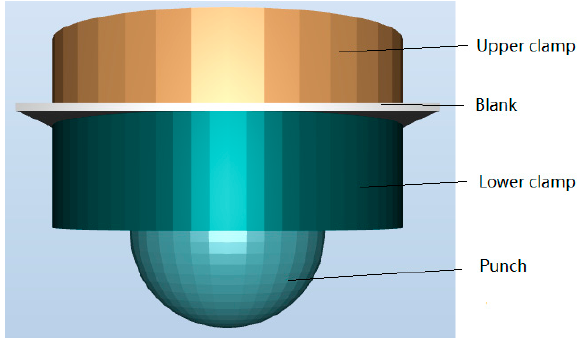
Figure 1. The set-up of finite element model of ForgeNxT